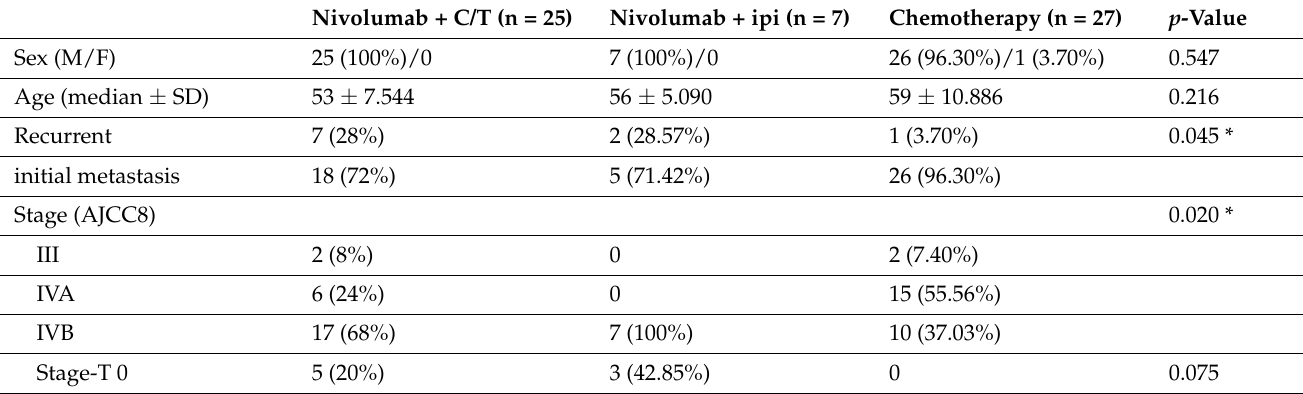
Table 1. Patients’